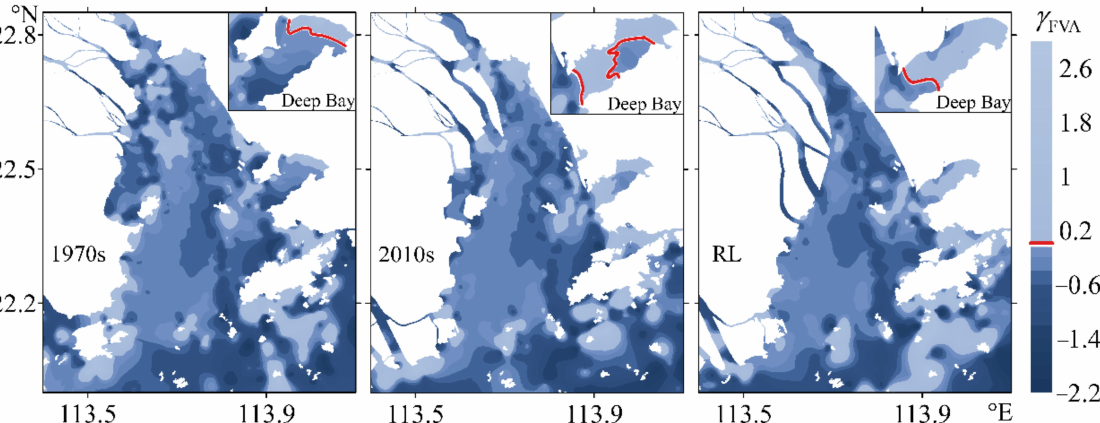
Figure 9. Variation of FVA with the shoreline change. The colors in the figure legend indicate the skewness values of FVA, and the red lines in the inserts are the contour lines of